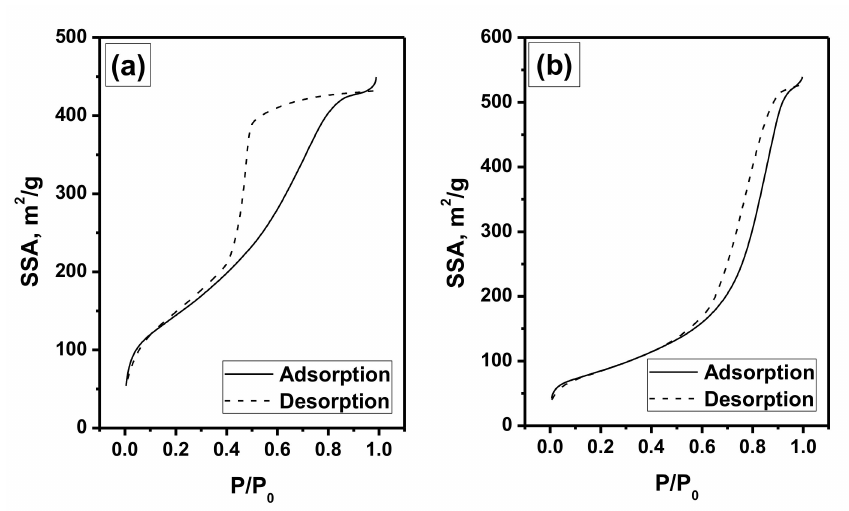
Figure 1. Low-temperature nitrogen adsorption / desorption isotherms of the Ni-Mo-Mg-OH ( a ) and Ni-Mo-Mg-O ( b ) samples.